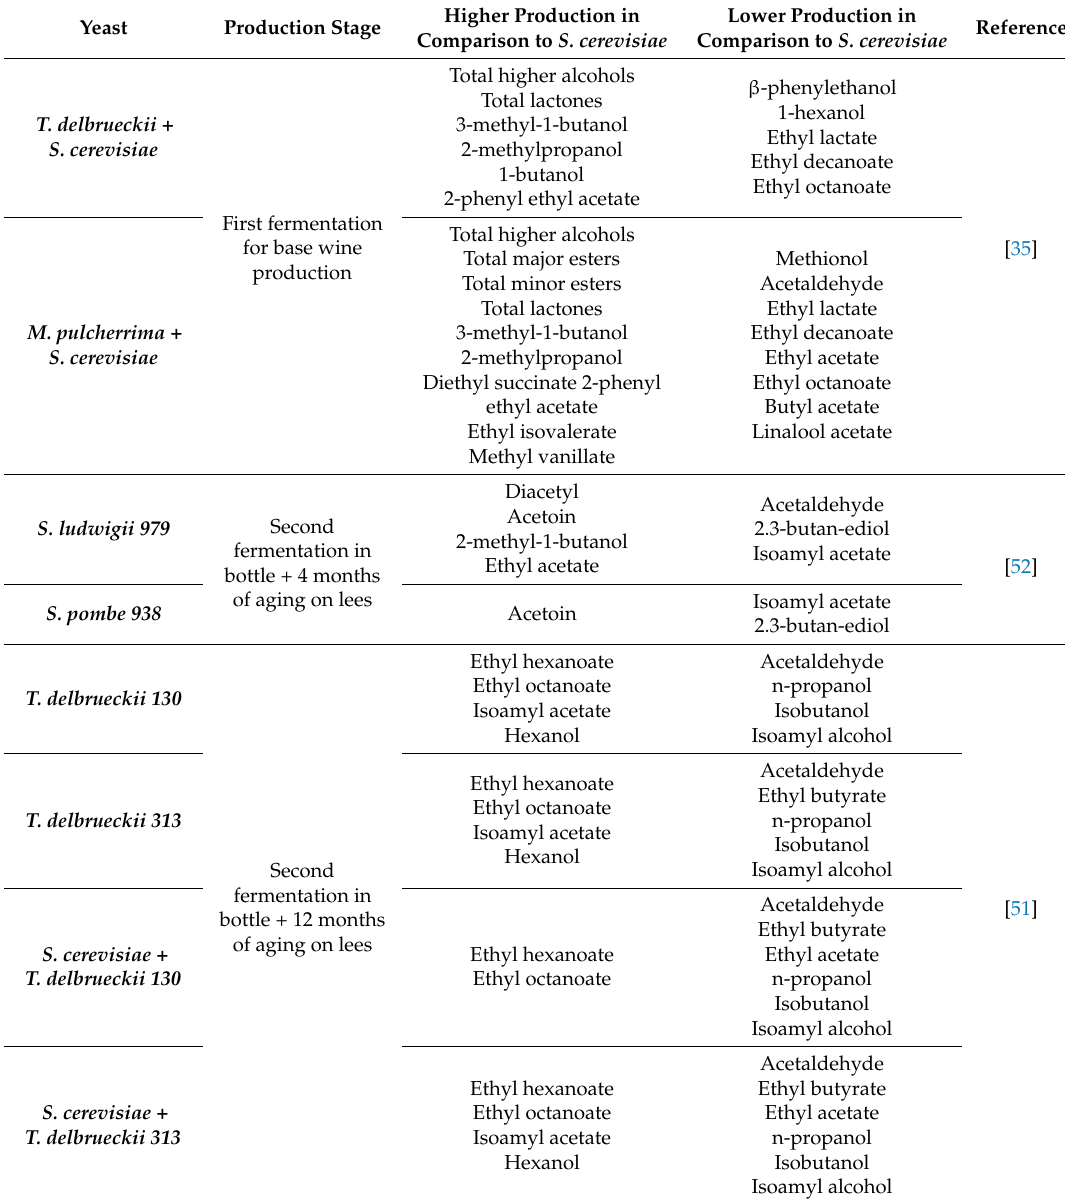
Table 2. Volatile aroma compounds (VOCs) studied in base wines and sparkling wines produced with non- Saccharomyces